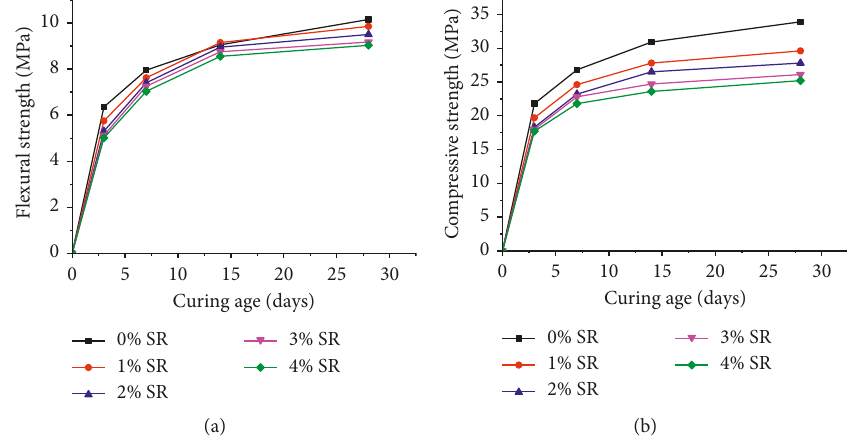
Figure 3: Mechanical properties of concrete with various SR contents. (a) Compressive strength. (b) Bending